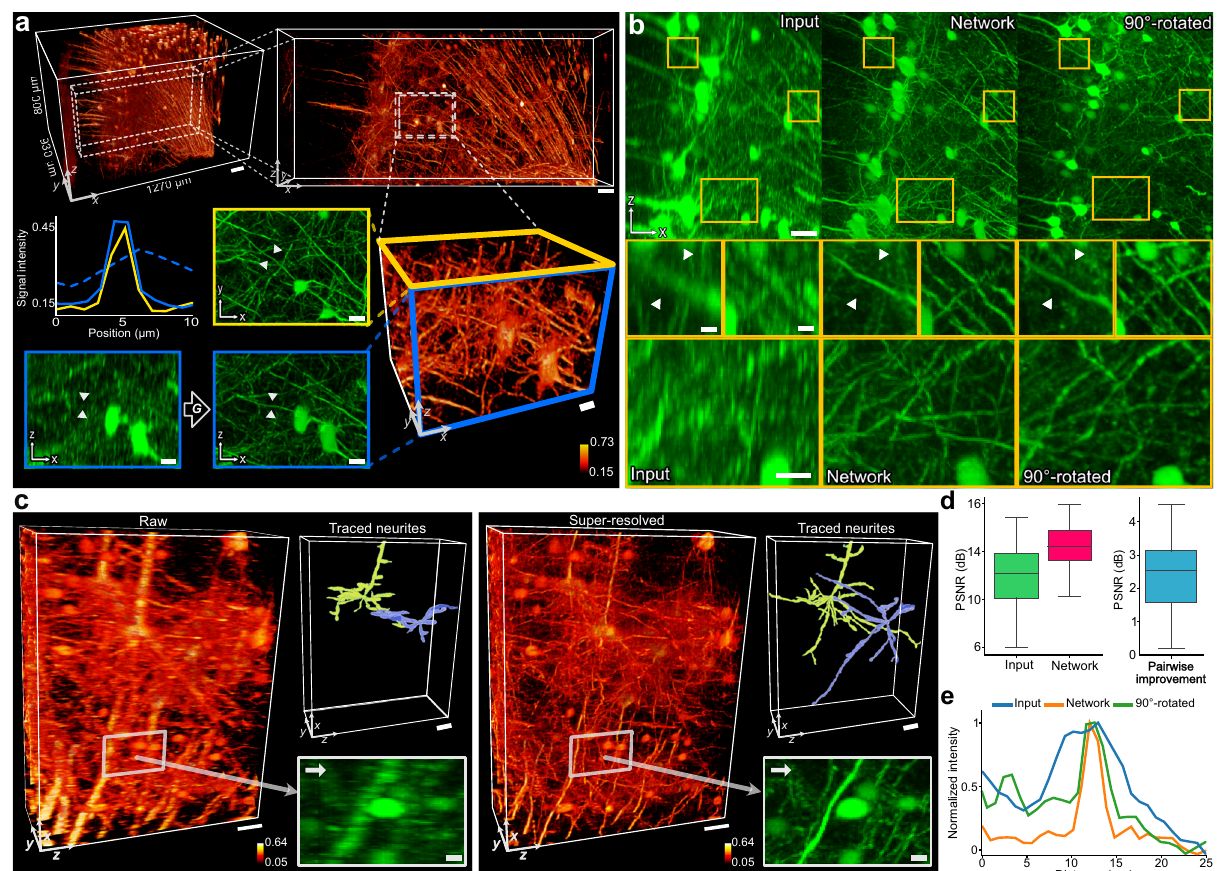
Fig. 2 Deep learning enables single-volume super-resolution for volumetric CFM. Cortical regions of a Thy 1-eYFP mouse brain were imaged. a Near isotropic resolution was achieved by the proposed method in a CFM volume. Axial images were blindly enhanced by the generative neural network, which is trained and tested on a single CFM volume that spans 1-2 gigabytes in memory. The resolution improvement in the axial planes was global and consistent throughout the image space (also see Supplementary Fig. 6). The converging cross-sectional intensity pro fi les of a cylindrical dendrite in the XY plane (yellow line) and XZ plane (blue line) indicate a near-perfect isotropic resolution in comparison to the input in XZ (dotted blue line), with XY FWHM of 1.71 µ m and XZ FWHM of 1.76 µ m, greatly reduced from input XZ FWHM of 6.04 µ m. Scale bars: 100 µ m, 50 µ m, 20 µ m (2D), and 20 µ m (3D) in the progressively zooming order. b Image restoration results ( “ Network ” ) show the upper cortical regions of the mouse cortex, as MIP images of 150- µ m thickness. The results were compared to the original axial imaging ( “ Input ” ) and reference lateral imaging ( “ 90°-rotated ” ). Zoomed-in ROIs are marked as yellow boxes. Suppressed or blurred details were recovered in the network output images and matched the lateral imaging. Scale bars: 50 µ m (top ROIs), 10 µ m (middle ROIs), 20 µ m (bottom ROIs). c 3D reconstruction of pyramidal neurons in the upper cortical layer before and after restoration, with neuronal tracings. Resolution improvement in the axial plane allows a more precise and detailed reconstruction of 3D neuronal morphology. We veri fi ed the additional neuronal tracings by substantiating in the corresponding locations from the lateral imaging. The under-sampling and the Z -blurring made it more dif fi cult to trace neurites that run perpendicularly to the scanning direction (arrows in 2D ROIs), whereas more accurate tracing was possible from the network output. Scale bars: 50 µ m (3D) and 10 µ m (2D ROI). d PSNR distribution of MIP images as a distance metric to the reference image, with pairwise improvements. MIP images ( n = 31 independent images) were from 140 × 140 µ m 2 cross sections with depths of 150 µ m. For the box plots, the box shows the IQR between Q1 and Q3 of the dataset, with the central mark showing the median and the whiskers indicating the minimum (Q1-1.5*IQR) and the maximum (Q3 + 1.5*IQR). e Cross-sectional intensity pro fi les from marked lines in zoomed-in ROIs from ( b ). The 90°-rotated line is registered to the input. In ( a ) and ( c ) panels, the color bars represent the signal intensity normalized between 0 and